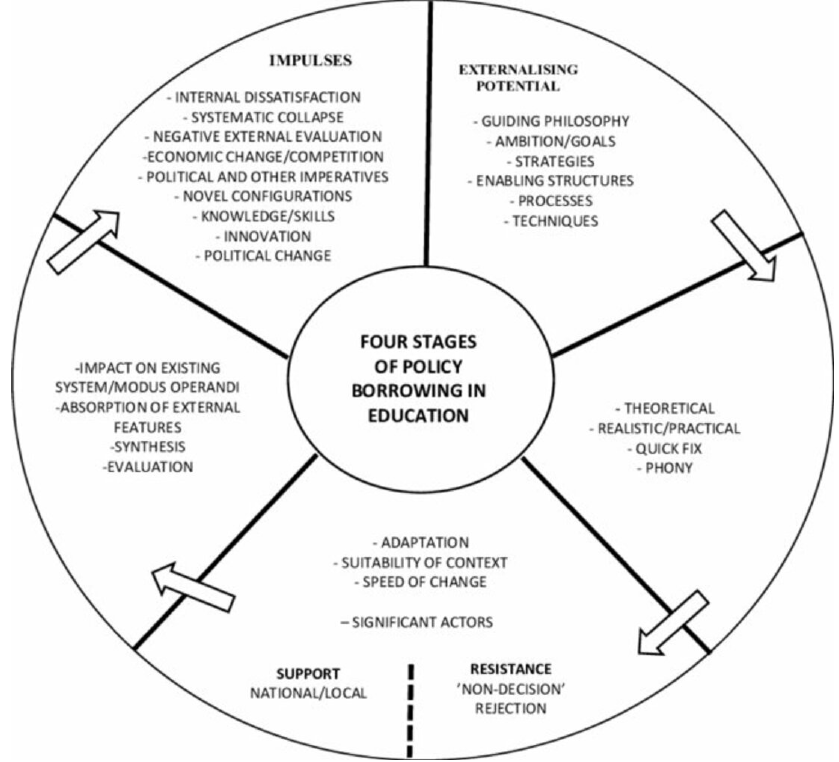
Figure 1. Policy borrowing in education: composite processes. From Phillips and Ochs (2004, p. 779).